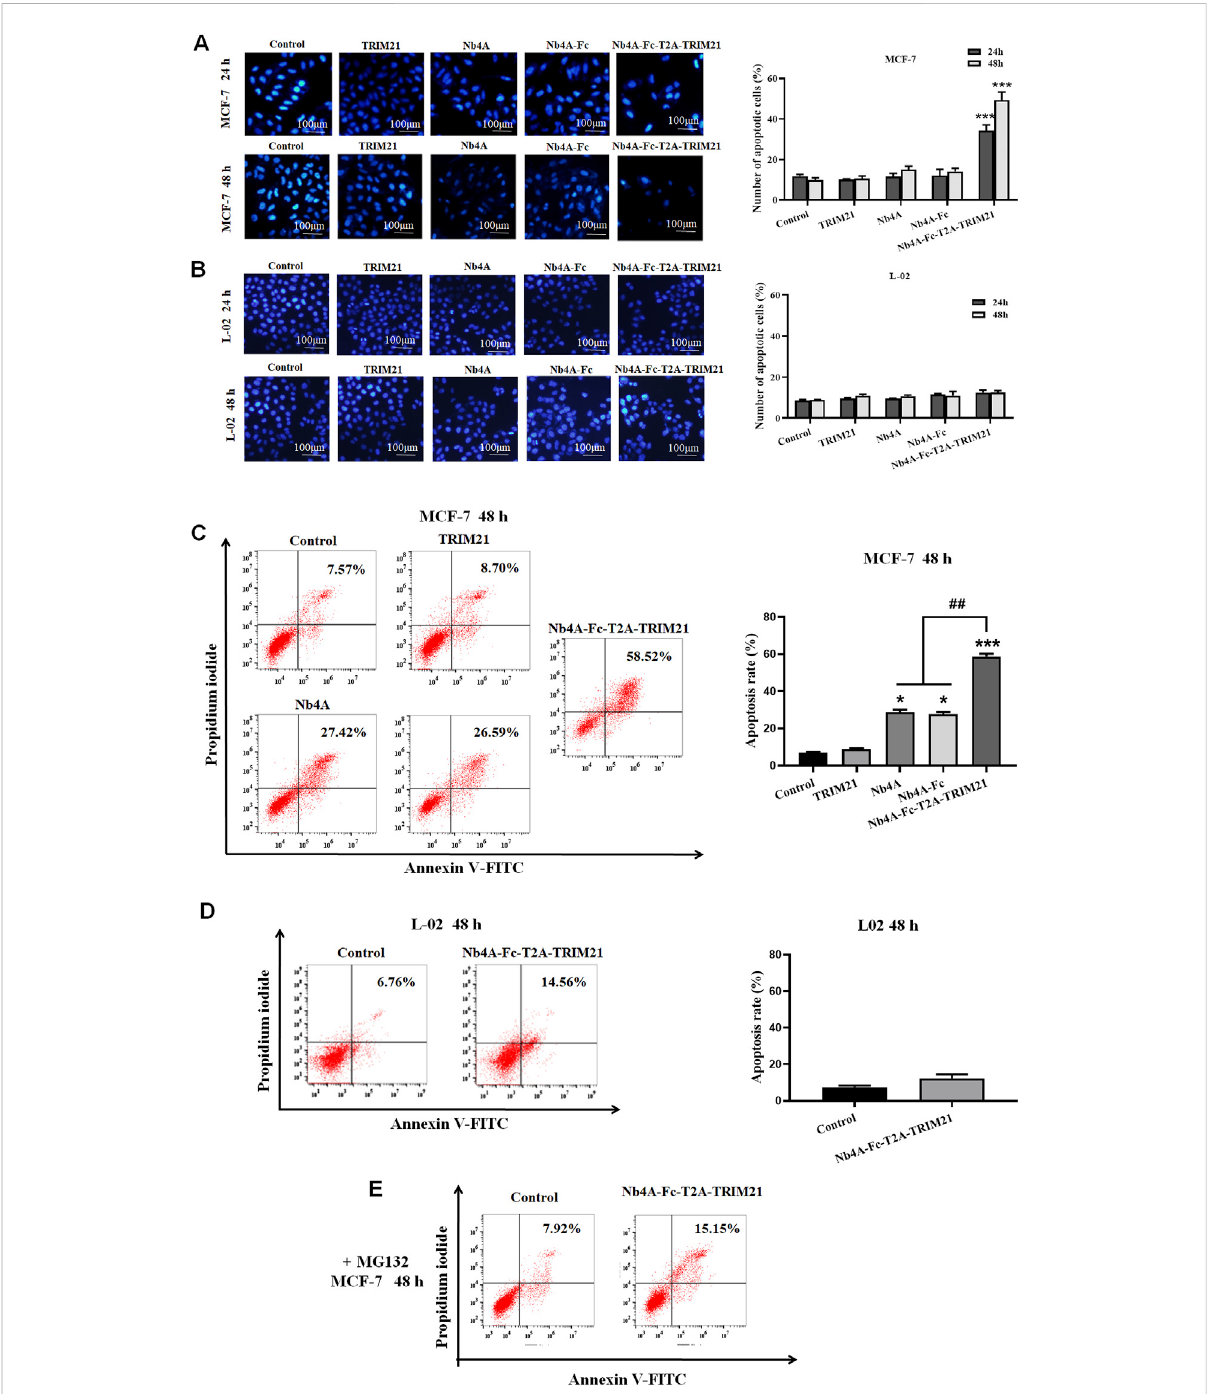
FIGURE 3 Pro-apoptotic effect of Nb4A-Fc-T2A-TRIM21. (A) Using Hoechst 33258 staining, the results of transfection of recombinant plasmids pcDNA3.1(+),pcDNA3.1(+)-Nb4A,pcDNA3.1(+)-Nb4A-Fc,pcDNA3.1(+)-TRIM21,andpcDNA3.1(+)-Nb4A-Fc-T2A-TRIM21 intoMCF-7cellsfor24 h and48 h,andthetotalpercentageofapoptoticcellsareshownright( n =3). (B) Hoechst33258stainingwasusedtotransfectL-02cellswithdifferent recombinantplasmidsfor24 hand48 h(bar=100 μ m),andthetotalpercentageofapoptoticcellsareshownright( n =3). (C) MCF-7cellswere transfectedwithdifferentrecombinantplasmidsfor48 h.TheapoptosisratewasdetectedbyFC,andthetotalpercentageofapoptoticcellsisshown right. (D) L-02 cells were transfected with recombinant plasmid pcDNA3.1(+)-Nb4A-Fc-T2A-TRIM21 for 48 h. The apoptosis rate was detected by FC, and the total percentage of apoptotic cells is shown right. (E) Apoptosis rate of MCF-7 cells transfected with different plasmids for 48 h was determined by FC with MG132 intervention ( n = 3). * p < 0.05 and *** p < 0.001 versus control and ## p < 0.01 versus the Nb4A-Fc-T2A- TRIM21 group. Data are expressed as mean ±